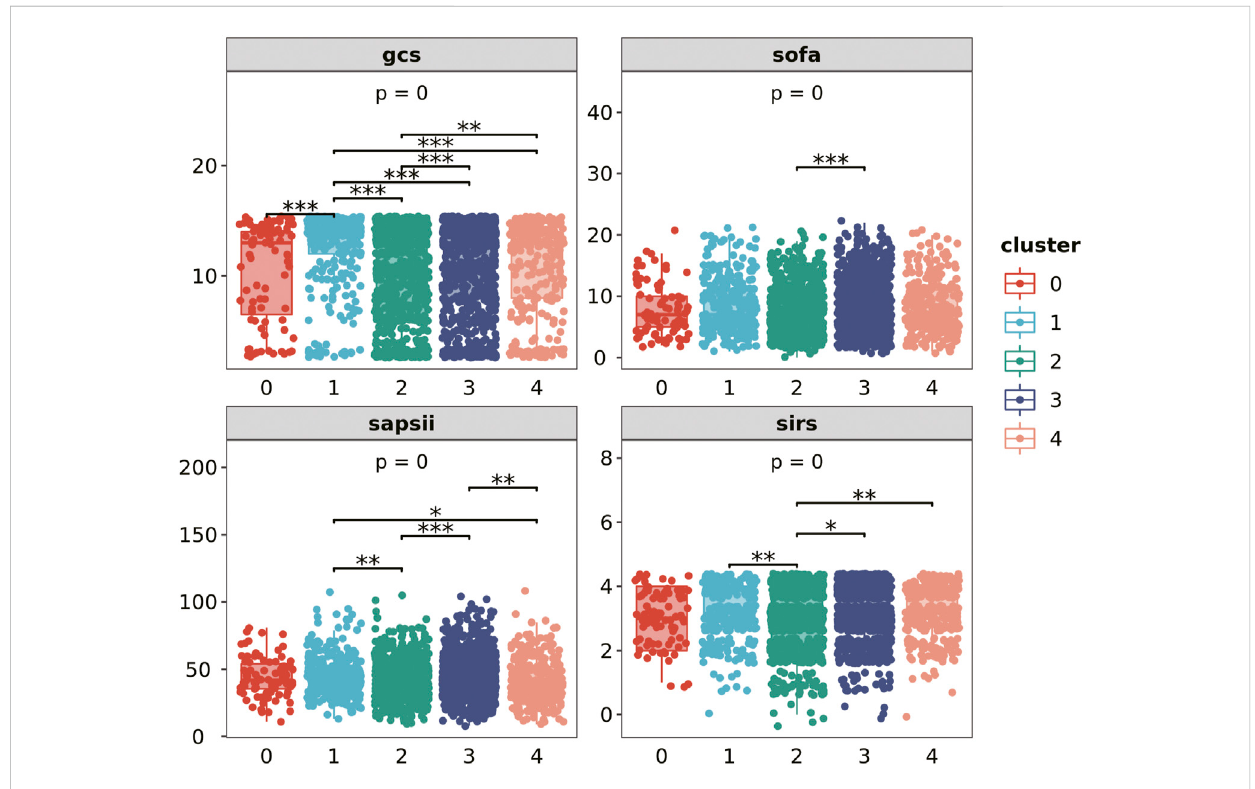
FIGURE 3 Severity of patients in each cluster on the fi rst